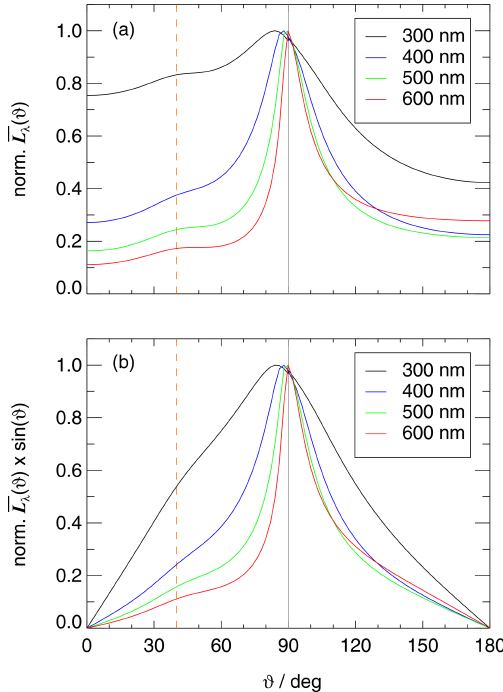
Figure 9. (a) Polar angle of incidence dependence of normalized, azimuthal mean diffuse spectral radiances for different wavelengths under the conditions in Fig. 8. (b) Azimuthal mean spectral radi- ances as in panel (a) but weighted with sin (ϑ) . The vertical grey line indicates the horizon and the dashed orange line the solar zenith angle. Direct sun contribution to spectral actinic flux densities for this scenario are 0.35 (300nm), 0.53 (400nm), 0.67 (500nm) and 0.73 (600nm). Compare with Fig.